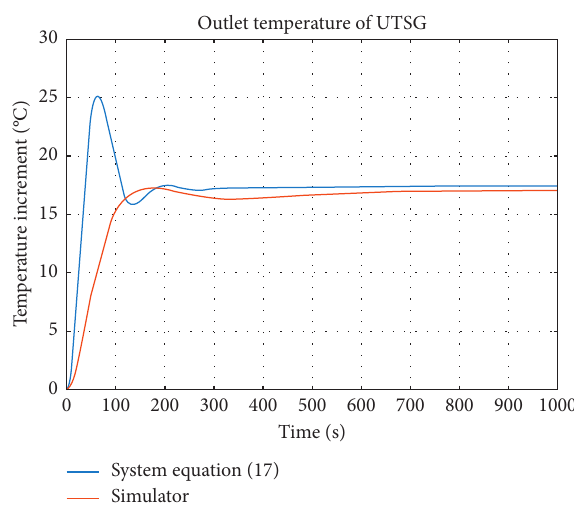
Figure 9: UTSG outlet temperature response of linear model equation (11) and Yangjiang NPP